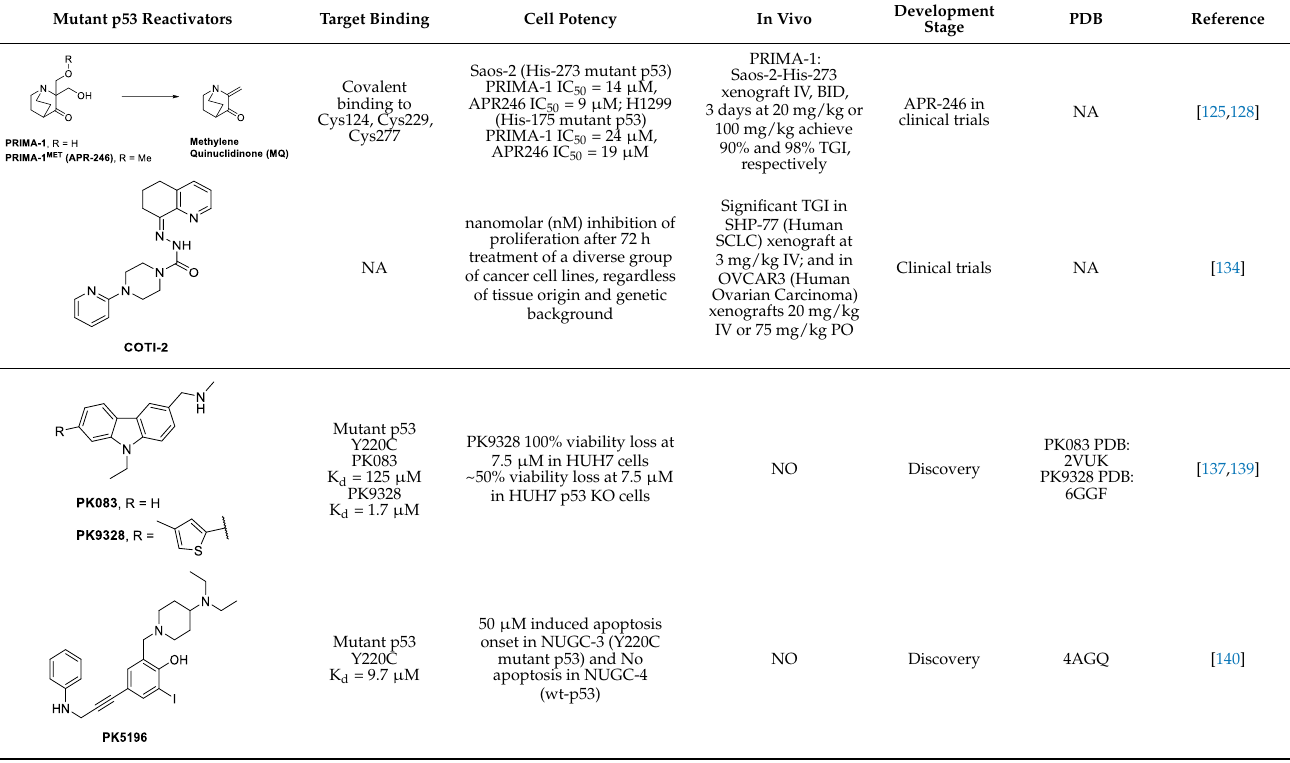
Table 4. Mutant p53 activators.